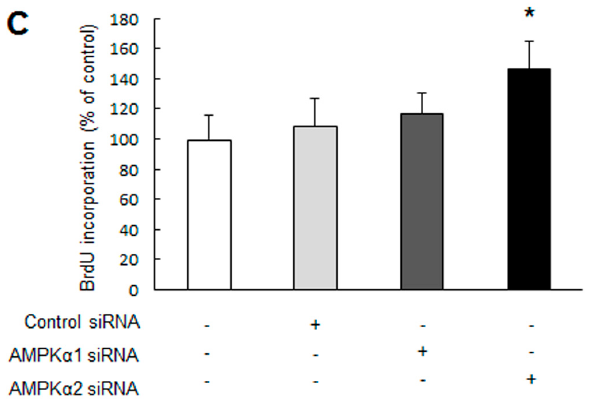
Figure 1. Knockdown of adenosine monophosphate-activated protein kinase α 2 (AMPK α 2) promotes pulmonary arterial smooth muscle cells (PASMCs) proliferation. Primary cultured PASMCs were transfected with AMPK α 1 or AMPK α 2 sequence-specific small interfering RNA